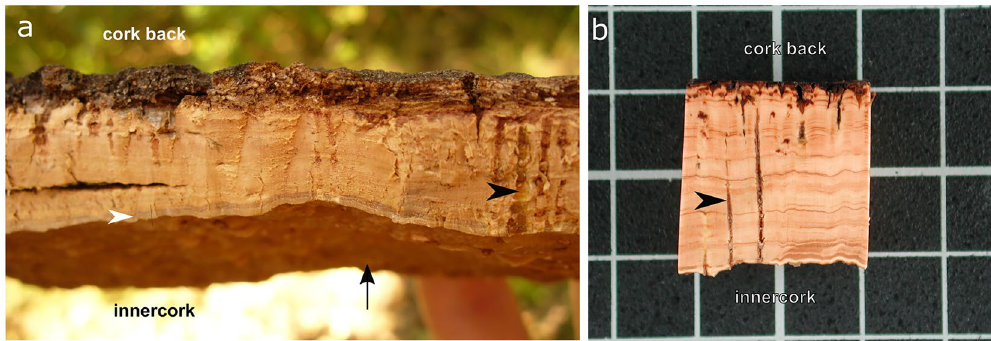
Figure 1. Anatomy of cork plank (outer bark) from Quercus suber. ( a ) Cork freshly-harvested at the late spring (June) in Romanyà de la Selva (Girona, Spain) showing this year produced living tissue (white arrowhead) in the innercork side, which faces the phellogen (black arrow). ( b ) A dried and polished sample is shown to better appreciate the annual cork-rings seen as lighter (earlycork) and darker brown (latecork) zones. Lenticels are highlighted with a black arrowhead. The grid scale distance in B corresponds to 1 cm. The figure was constructed using the free and open source Inkscape software 1.0 (https:// inksc ape.